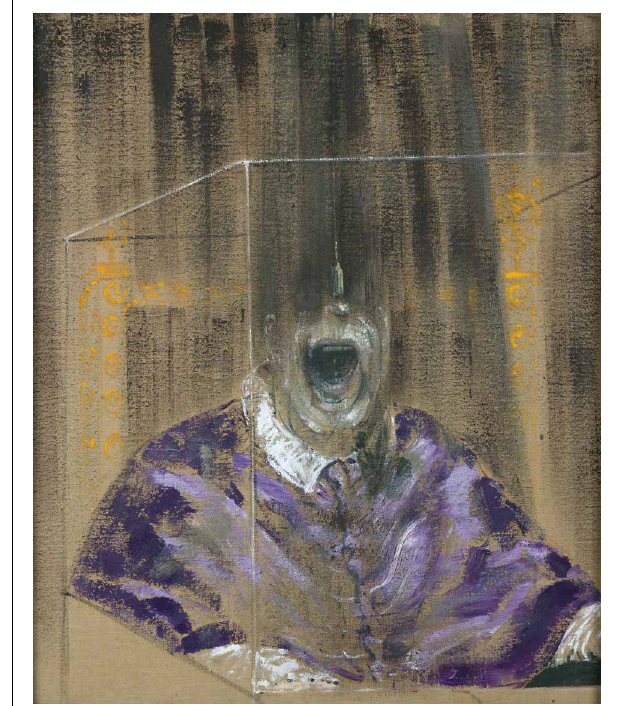
FIGURE 8 | Francis Bacon— Head VI, 1949. © The Estate of Francis Bacon. All rights reserved. DACS 2013.